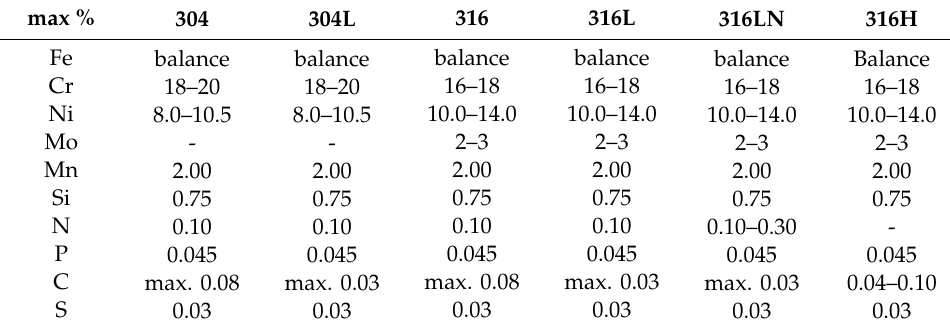
Table 1. Typical chemical composition of 304, 304L, 316, 316L and 316LN austenitic stainless steel. (Data from www.azom.com).